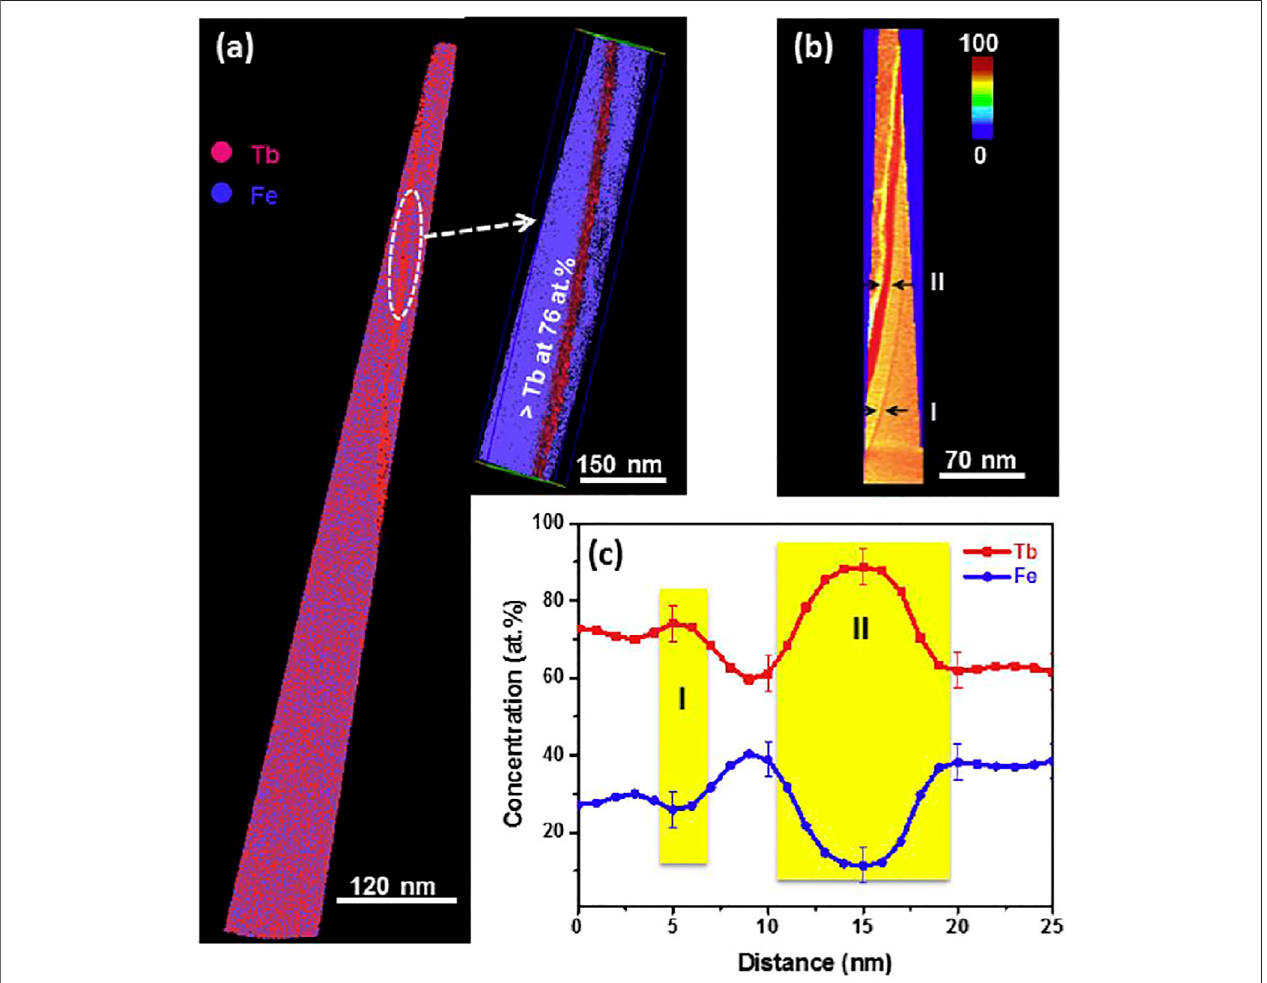
FIGURE 4 | Atom probe tomography image of the shear bands (A,B) found for the Tb 75 Fe 25 nanoglass subjected to severe plastic deformation by HPT. The chemical composition pro fi les of Tb and Fe across the shear bands indicate the compositional fl uctuation. (C) The image was adapted from Singh et al. (2020a).